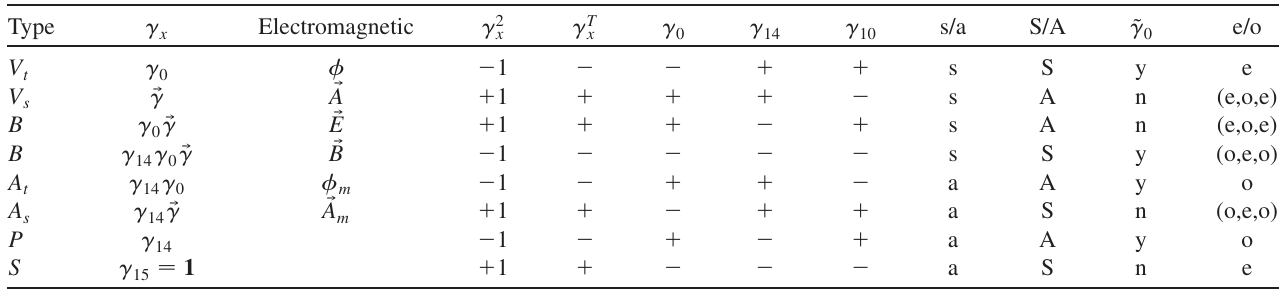
TABLE I. Properties of the real (cid:1) matrices. The type encoding is V for vectors, B for bivector, A for axial vector, P for pseudoscalar, and S for scalar and refers to the symplectic transformation properties. The subscripts t ( s ) indicate time(space)like components of a gives the sign s that fulfills the following equation: (cid:1) 4-vector, respectively. The column labeled (cid:1) a is a symplex or an antisymplex, respectively. Accordingly, the column labeled ‘‘S/A’’ tells if (cid:1) ‘‘s/a’’ indicates whether (cid:1) x symplectic or antisymplectic, respectively. The column labeled ‘‘e/o’’ indicates whether the corresponding (cid:1) matrix is even or odd. Even matrices are nonzero only in the block-diagonal components, odd matrices are zero in the block-diagonal components. Finally, denotes if a basis exists such that (cid:1) appears as the ‘‘time direction,’’ i.e., if a basis exists in which (cid:1) the column labeled ~ (cid:1) x 0 . This is only the case for antisymmetric matrices, which are either both a symplex and symplectic or none of role of (cid:1) 0